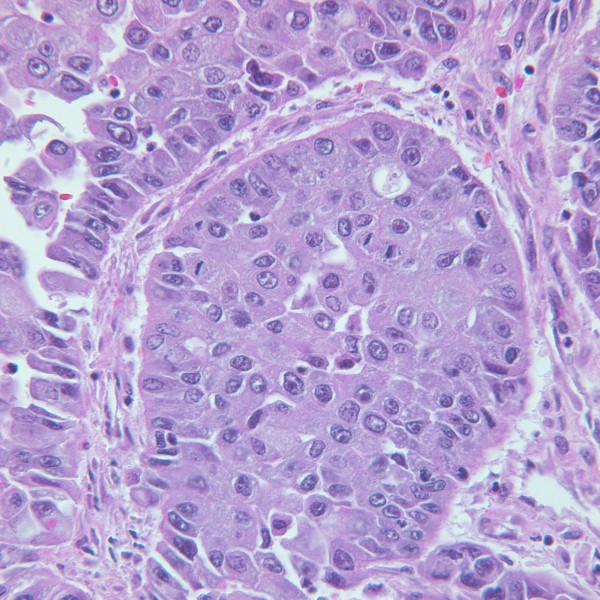
Histological examination of the cystectomy specimen showing poorly differentiated high-grade transitional cell carcinoma. (Hematoxylin and eosin section, original magnification×220).